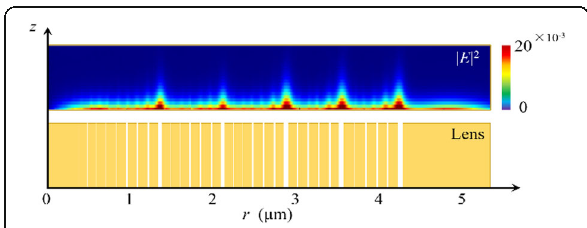
Fig. 7 Intensity distribution pattern in the lens region and its cross- sectional view. The transmission distance of the non-SP waves in nanorings is proportional to the slit